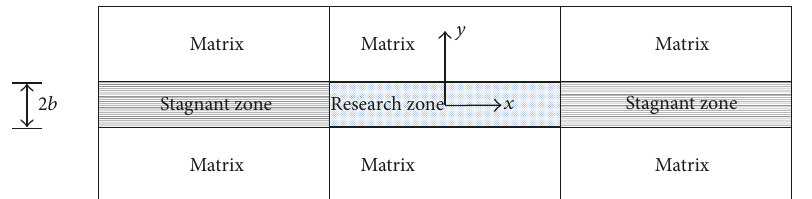
Figure 2: Fracture with an aperture of 2 𝑏